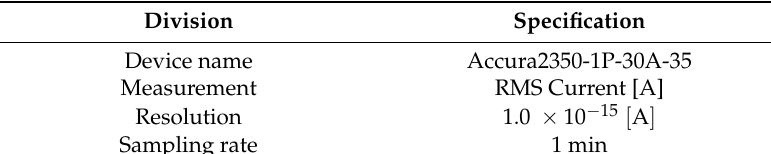
Table 3. Specifications of measuring equipment [27].